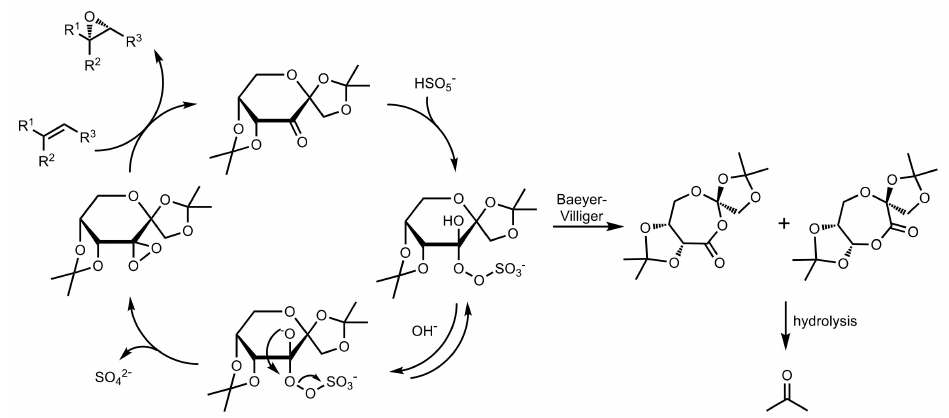
Epoxidations by active dioxirane species are possible in two orientations, either spiro or planar, with respect to the vinyl group. All possible transition states are shown in Figure 20. Among them, only two of the transition states are not sterically hindered: spiro A and planar G , with the former preferred as revealed by the analysis of the structure of products [74].